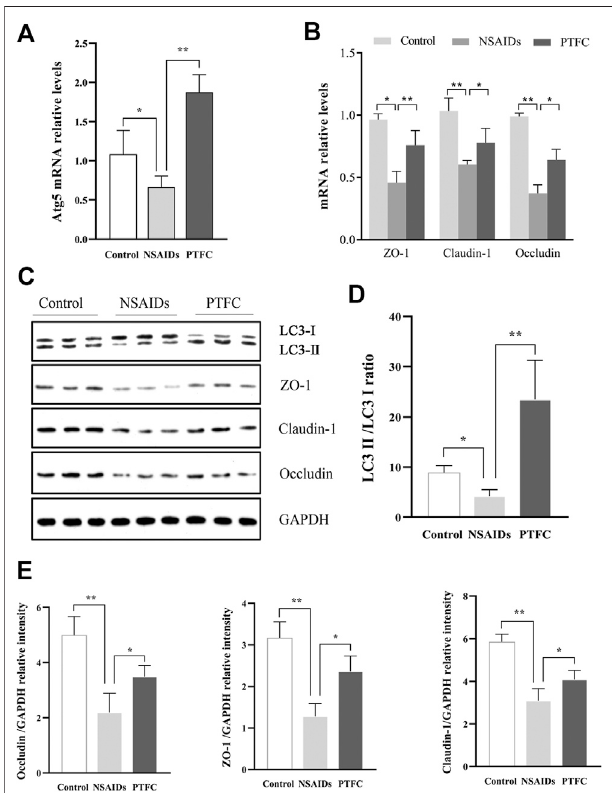
FIGURE5| PTFCpromotesautophagyandincreasesTJ-relatedprotein levelsinIEC-6cells.IEC-6cellswereuntreatedforthe48 hofculture(Control), treated with diclofenac for the 48 h of culture (NSAID), or treated with diclofenac for the 48 h of culture plus treatment with PTFC for the fi nal 24 h or culture (PTFC). The mRNA levels were then detected in all groups using quantitative reverse transcription-polymerase chain reaction (qRT-PCR) (A) mRNA levels of autophagy-related 5 (Atg5) (B) mRNA levels of ZO-1, CLDN1, and OCLN (C) Western blot analysis was used to determine protein expression levels in the groups of cells (D) Levels of light chain 3 (LC3) were determined and the signal intensity ratio of LC3-II/LC3-I density ratio was calculated using ImageJ software (** p < 0.01) (E) Protein expression of ZO-1, CLDN1, and OCLN was measured in all groups using western blotting (* p < 0.05 and ** p < 0.01).